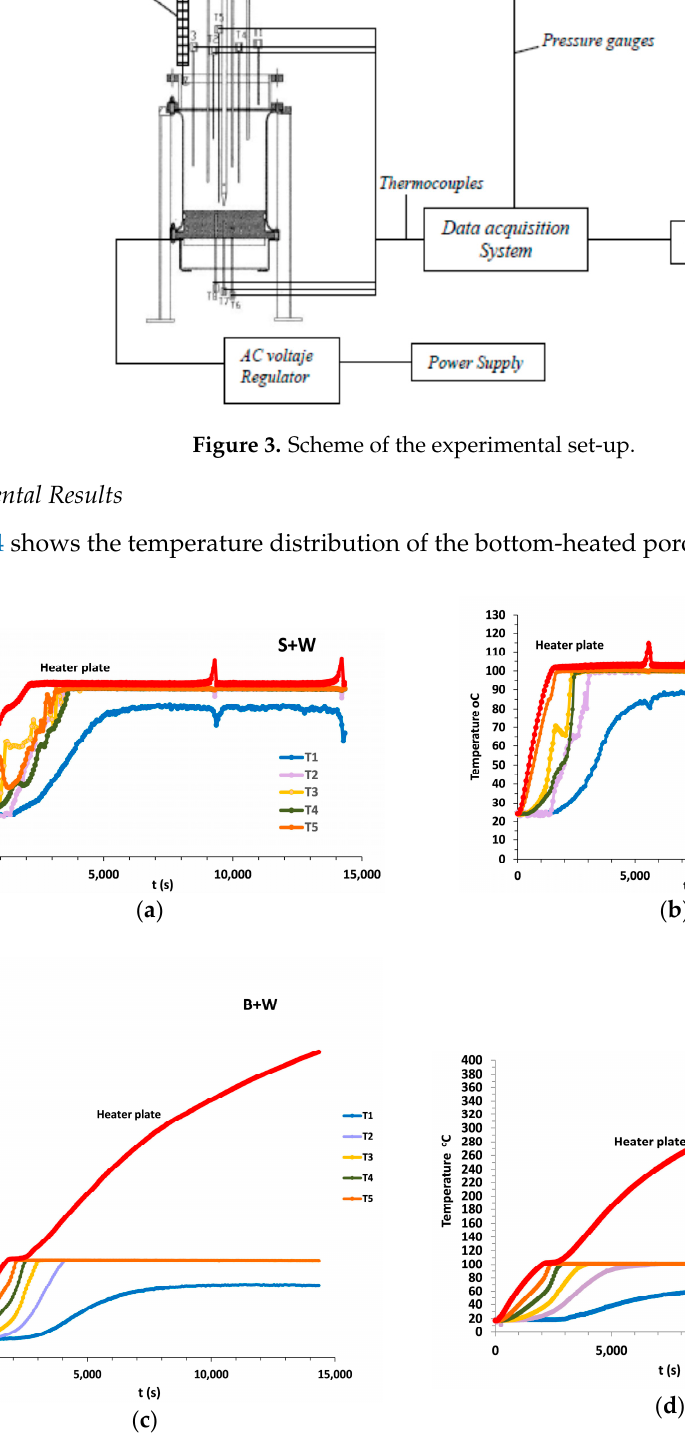
Figure 4. Temperature distribution: ( a ) S+W, ( b ) S+DS, ( c ) B+W and ( d ) B+DS.